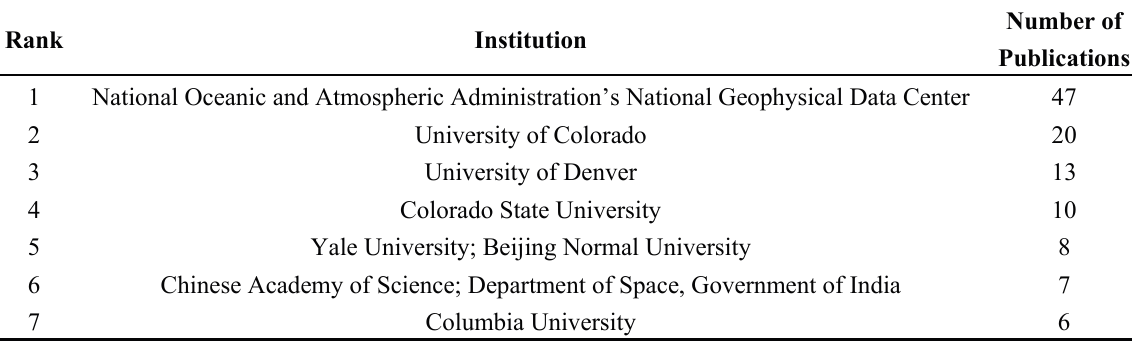
Table 4. Top seven most productive